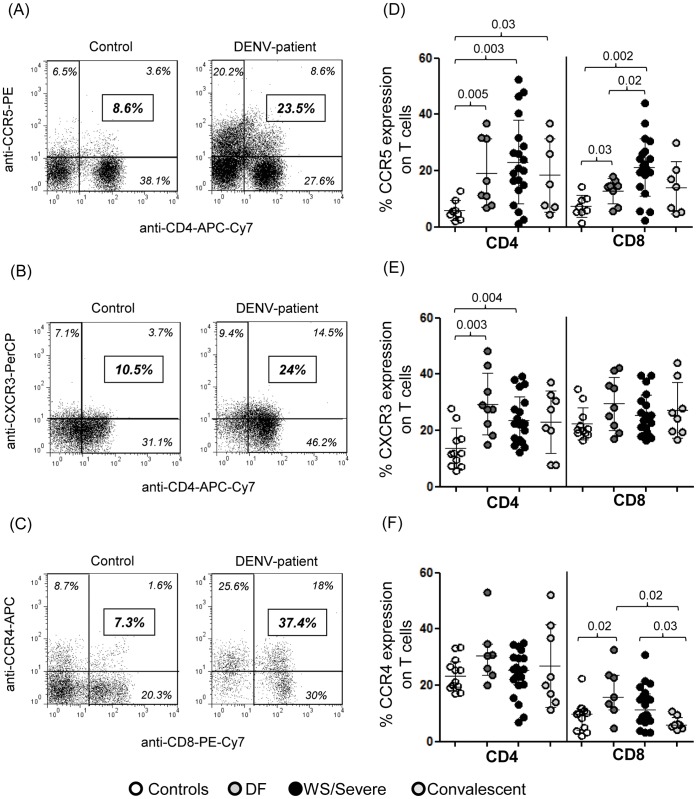
Expression of CCR5, CXCR3 and CCR4 on T cells from DENV-patients and healthy controls.Representative dot plots showing the expression of CCR5 (A), CXCR3 (B) and CCR4 (C) on CD4 or CD8 T cells in one healthy control and one DENV-patient. The values in italics in each region of the quadrants indicate the values of cells’ frequency of the quadrants. The bold-, italic and framed numbers on the right indicate the percentages of chemokine receptors among T cells. (D) Percentage of CCR5-expressing among CD4+ or CD8+ T cells; (E) percentage of CXCR3-expressing among CD4+ or CD8+ T cells; (F) percentage of CCR4-expressing among CD4+ or CD8+ T cells. Horizontal bars indicate the mean values, standard deviation for each population. Appropriate matched isotype control antibodies were used to discriminate between positive and negative populations. The Mann–Whitney U-test was used to analyze differences between control and patient groups. Statistically significant P values for differences between patients and controls are shown above the figures.